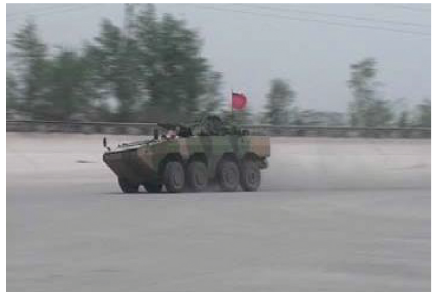
Figure 1: 8 × 8 prototype vehicle. Table 1: The basic structure parameters of the